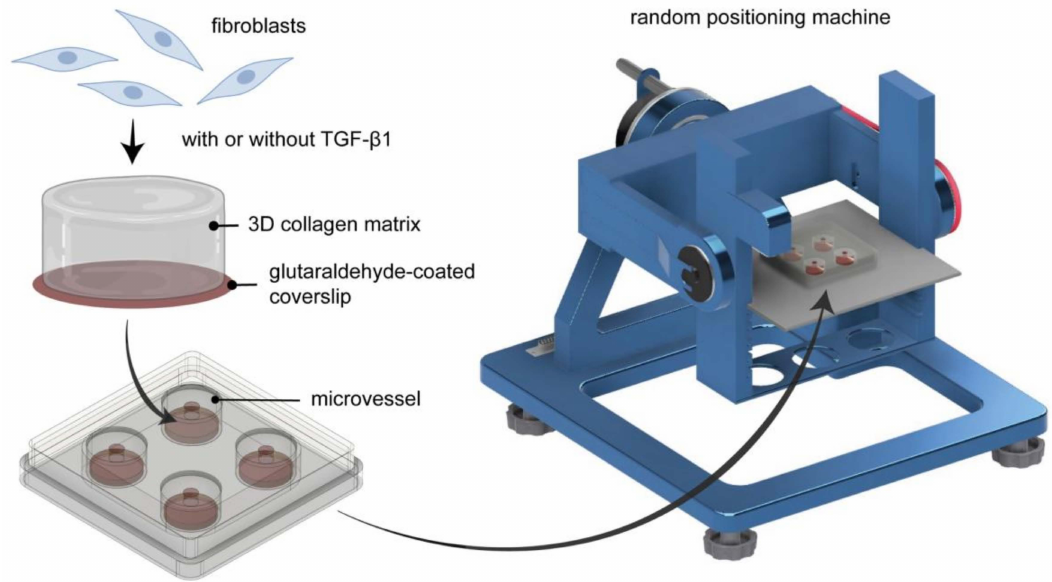
Figure 1. Schematic illustration of experimental setup. Fibroblasts were cultured in 3D collagen matrices and placed inside engineered biocompatible microvessels before being cultured either on 1 g or on the random positioning machine (RPM). RPM is placed in a conventional cell culture